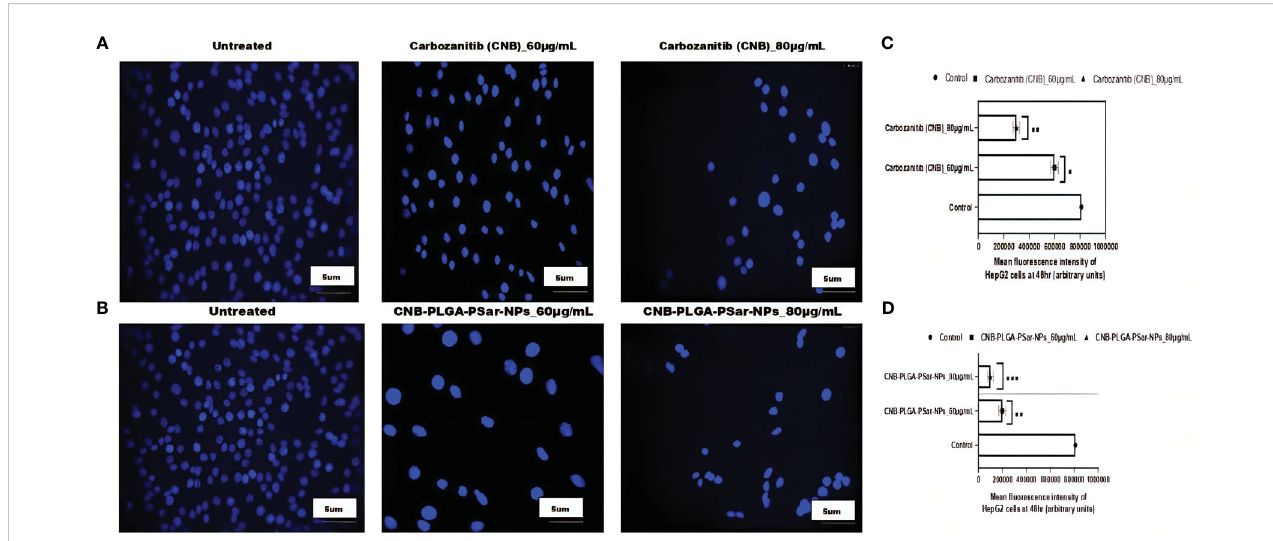
FIGURE 4 Carbozanitib (CNB)-induced apoptosis and DNA damage in hepatocellular carcinoma cell line (HepG2) cells as examined by DAPI staining. HepG2 cells exposed to different concentrations of CNB-loaded CNB-PLGA-PSar-NPs and free CNB for 48 h and apoptosis was determined by DAPI staining by fl uorescence microscopy. (A) represented the control (untreated), CNB 60 m g/mL, and CNB 80 m g/mL, respectively. (B) represented the control (untreated), CNB-PLGA-PSar-NPs 60 m g/mL, and CNB-PLGA-PSar-NPs 80 m g/mL, respectively. (C) Mean fl uorescence intensity of HepG2 cells at 48hr when treated with 60 and 80 m g/mL of CNB. (D) Mean fl uorescence intensity of HepG2 cells at 48hr when treated with 60 and 80 m g/mL of CNB-PLGA- PSar-NPs. Data are presented as mean ± SD. The graph represents data from two independent experiments. p<0.05, student